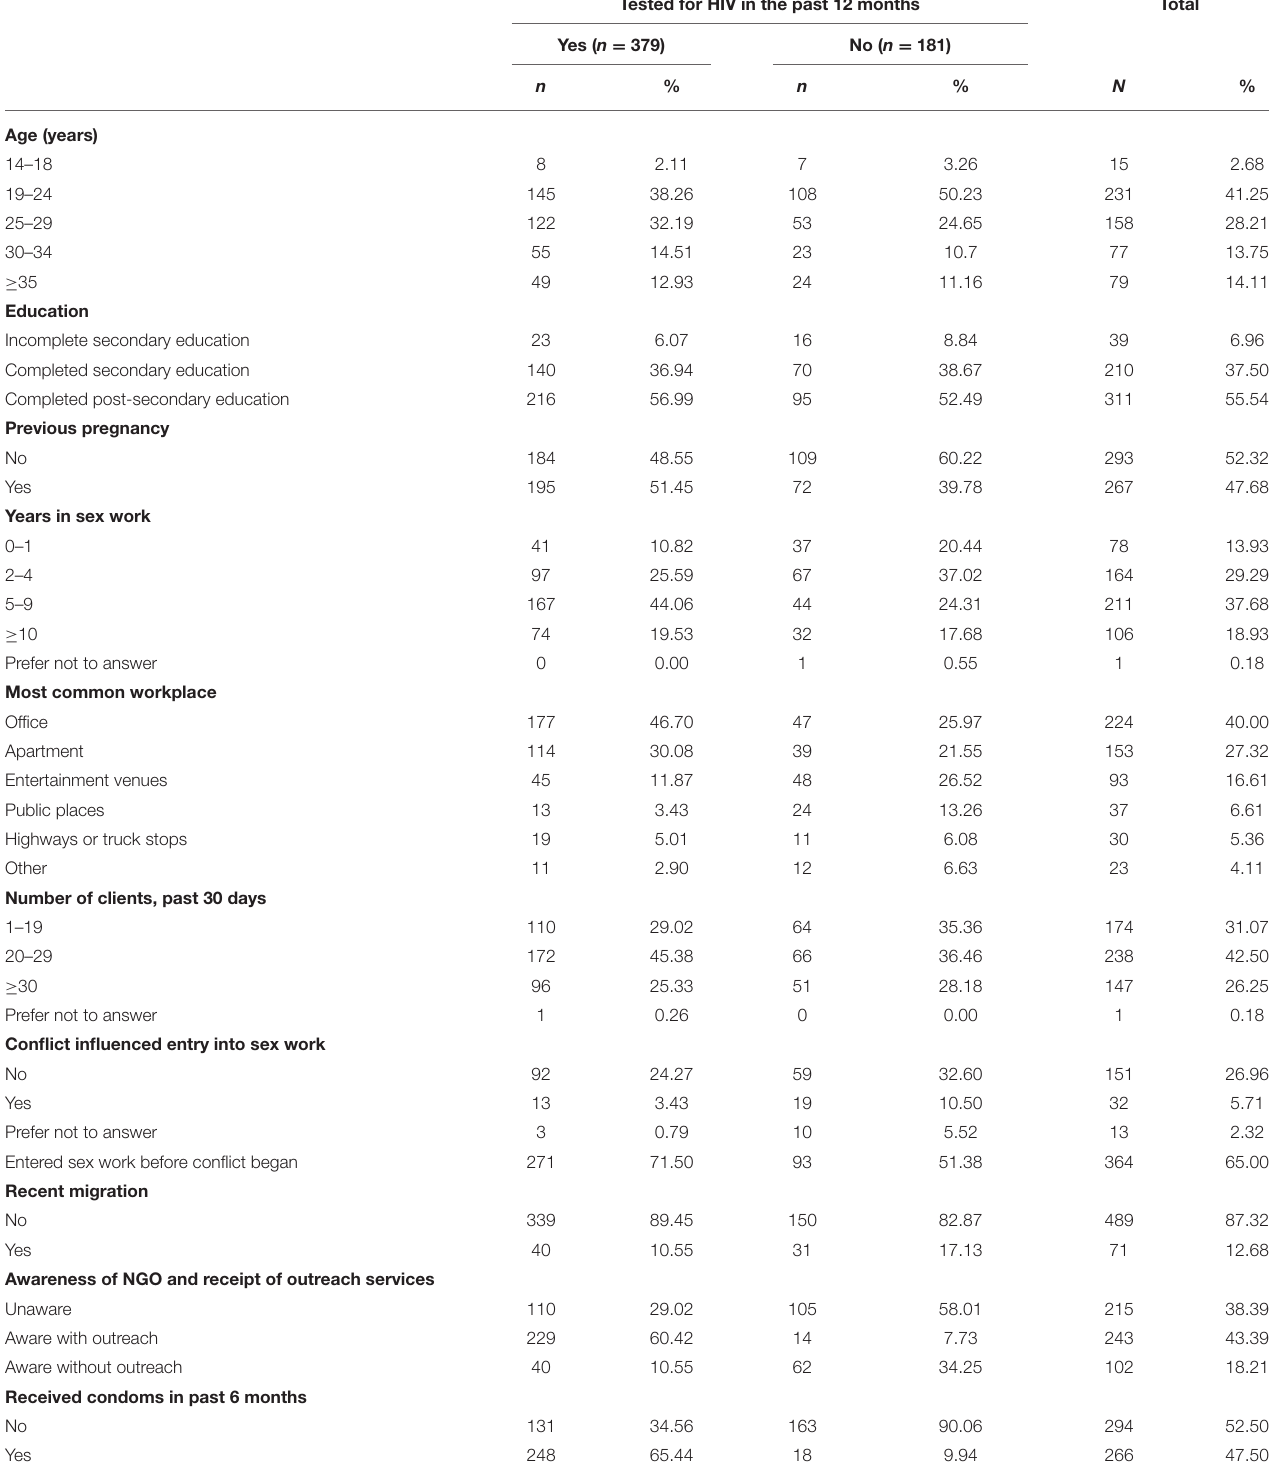
TABLE 2 | Socio-demographic characteristics of sex worker participants, by HIV testing in the past 12 months ( N =